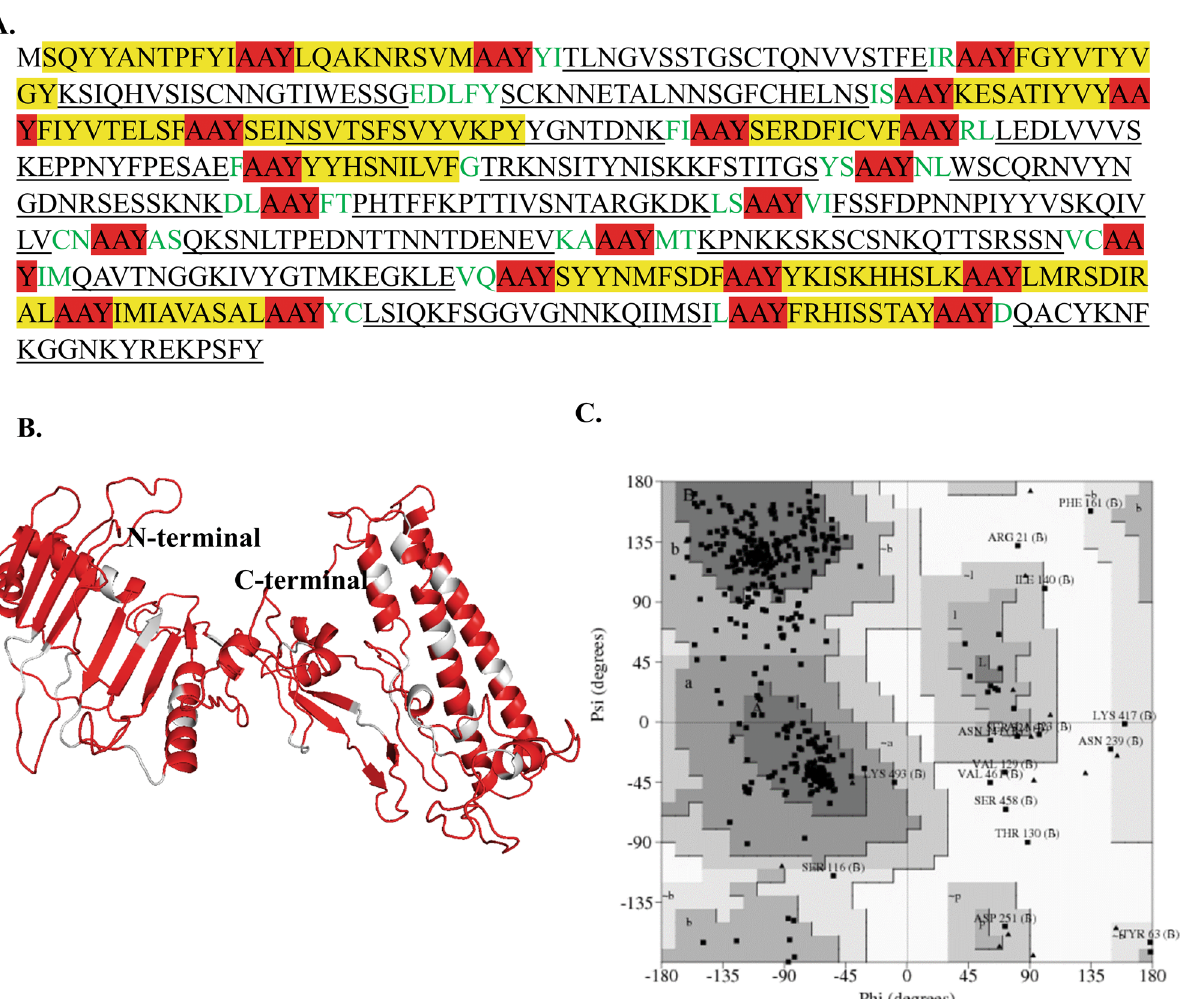
Figure 2. Modeled structure of multi-epitope protein against LSDV. ( A ) Protein sequence of multi-epitope protein. Sequence in underline: B-cell epitope; yellow color: CTL epitope; green color: extra sequences for the stability of multi-epitope protein; Highlight red color: AAY linker, ( B ) Three-dimensional model of multi- epitope protein obtained by modeling and refinement by RaptorX. The gray color represents AAY linker, ( C ) Ramachandran plot analysis of the multi-epitope protein showing favored (80.3%), allowed (16.3%), generously allowed (1.9%), and disallowed regions